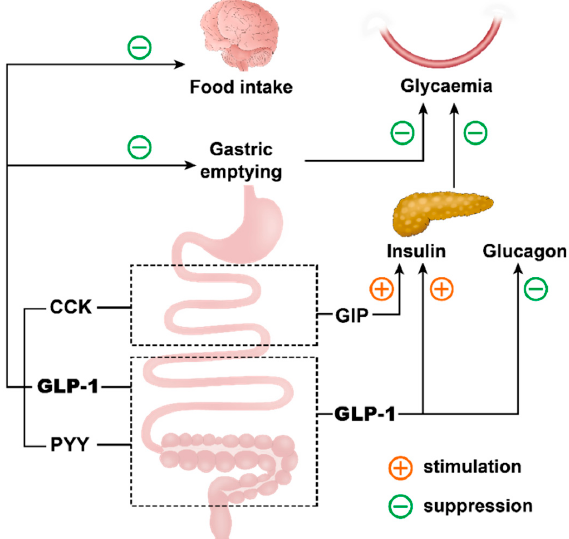
Figure 2. The roles of gastrointestinal hormones, including cholecystokinin (CCK), glucose-dependent insulinotropic polypeptide (GIP), glucagon-like peptide 1 (GLP-1) and peptide YY (PYY), released in response to meal ingestion, in the regulation of gastric emptying, postprandial glycemia and energy intake.